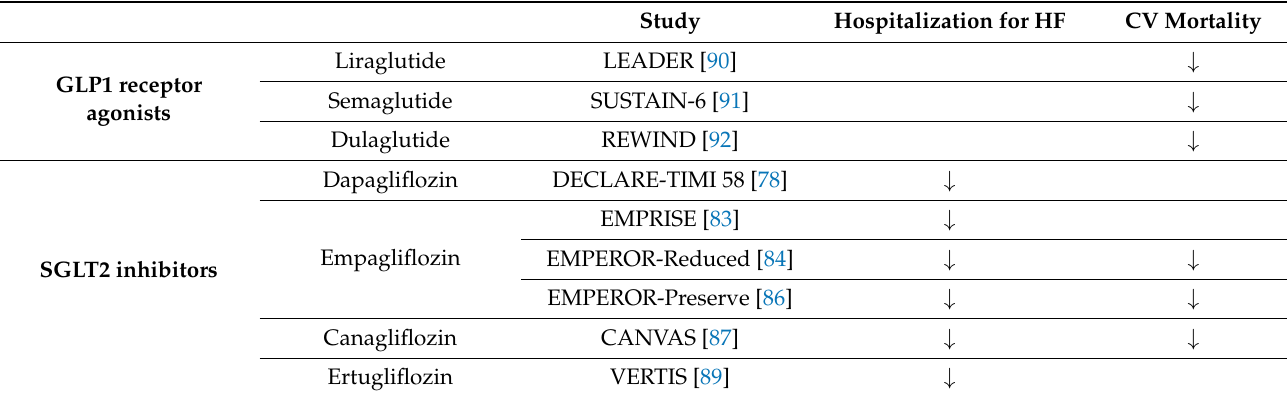
GLP1: glucagon-like peptide 1; SGLT-2: sodium-glucose cotransporter 2; HF: heart failure; CV: